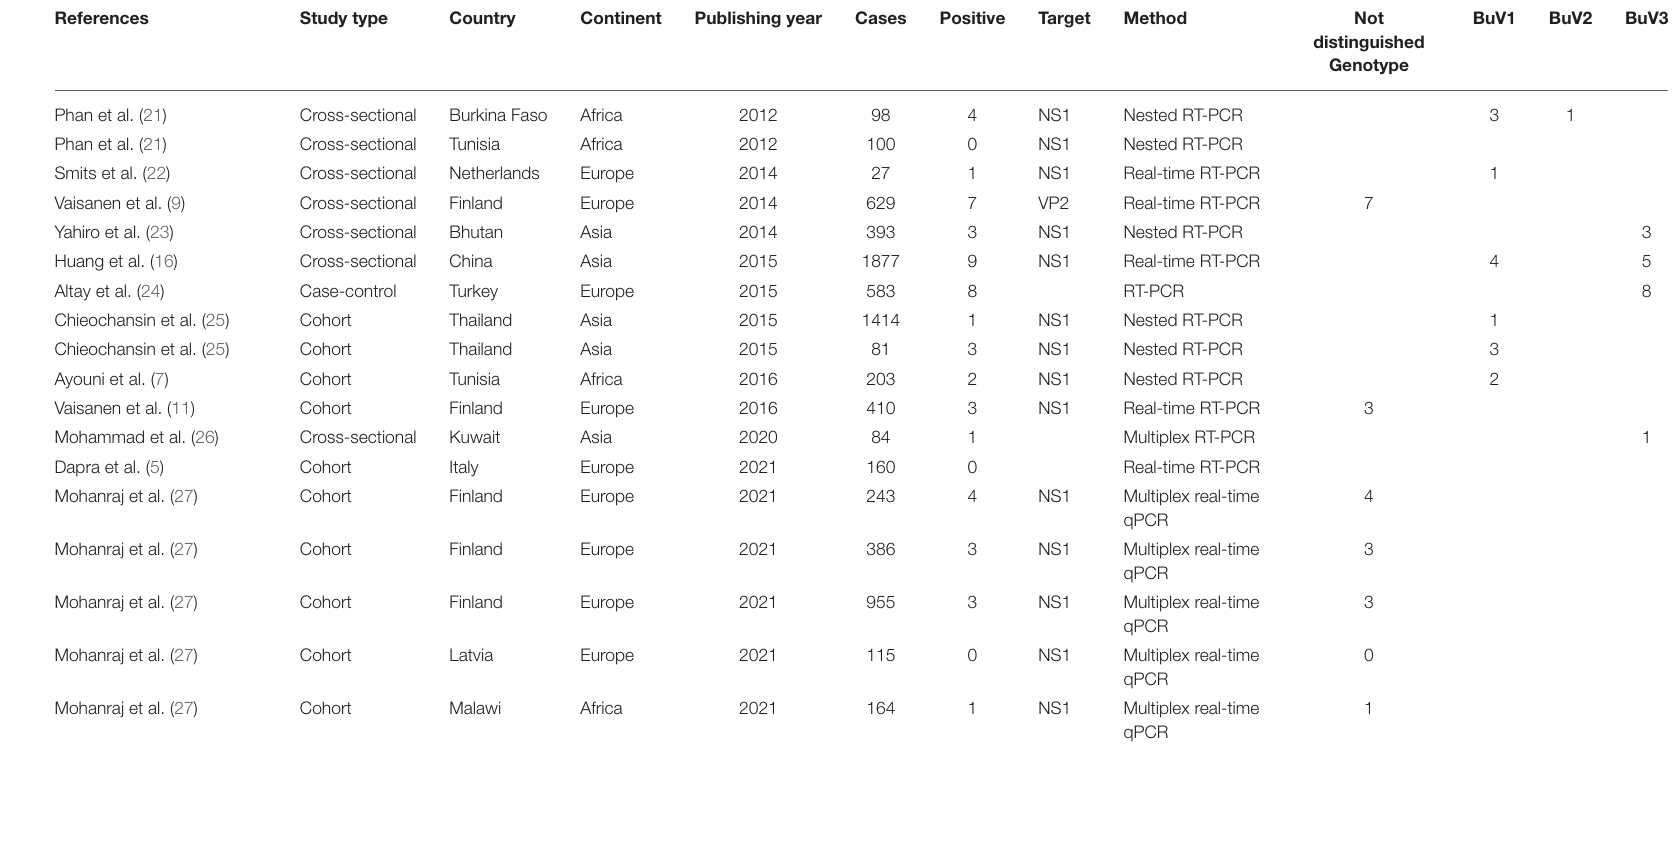
TABLE 1 | The general characterization of Bufavirus